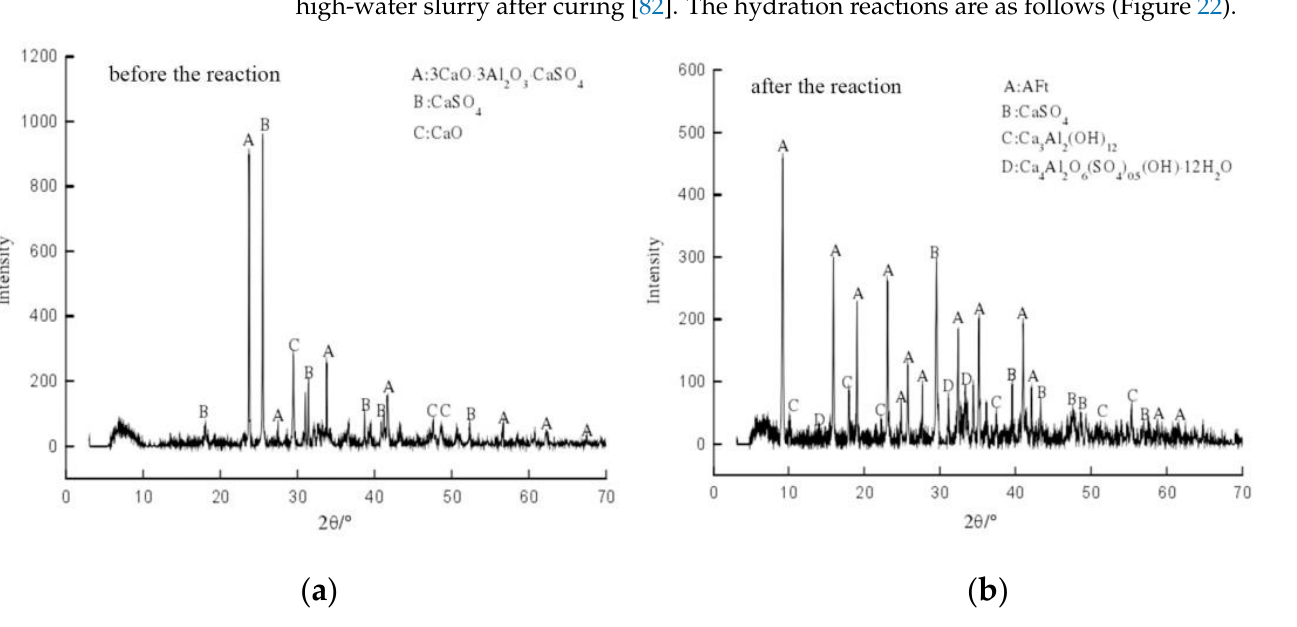
Figure 23. Microstructural diagram of high-water material after a hydration reaction (1 d, 3 d, and 7 d). Molecular structure of ettringite in high-water consolidation (A-Al, C-Ca, H-OH, and W-H 2 O) [86]. Ettringite crystals are composed of six calcium atoms arranged in an oriented man- ner, and their basic structure is columnar. Each calcium atom can have four water mole- cules attached to it. On the outer side, parallel to the vertical axis, there are four grooves, three of which each combine one sulfate ion and two water molecules. Therefore, a total of 32 water molecules are required for the formation of complete ettringite cells, account- ing for 81.16% of the total volume of ettringite crystals. The amount of water crystal in ettringite is related to the ambient humidity. Among the 32 water molecules consolidated on ettringite crystals, 24 are bound water and 8 are crystallized water. The 24 bound water molecules can be divided into two parts: primary